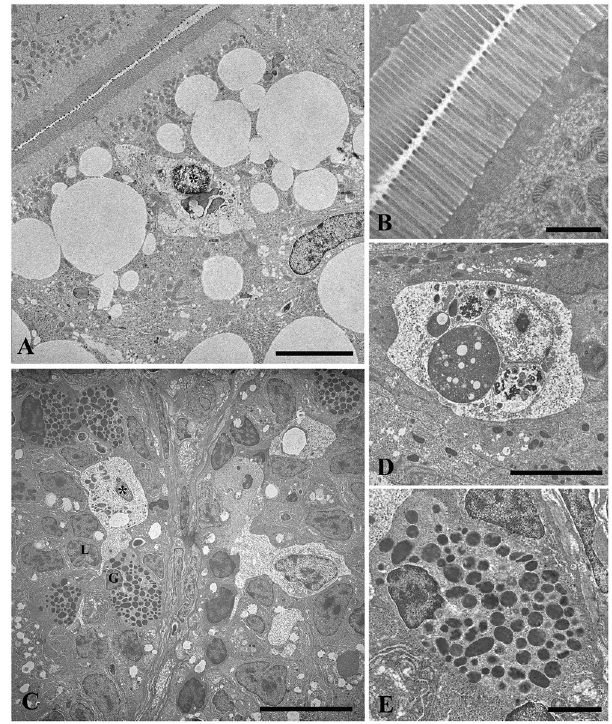
Figure 6. Elevated fat content increases lipid droplets, but did not alter intestinal mucosal epithelium in zebrafish fed a HFD, MFD and LFD. TEM micrograph showing large lipid droplets accumulation in the apical epithelium of enterocytes and intraepithelial macrophages in HFD-C fed fish ( A ). Intact brush border in HFD-C fed fish, ( B ). Macrophages in MFD-C fed fish in contact with the cell membrane of infiltrated lymphocytes and granulocytes ( C ). Intraepithelial macrophages with typical features of phagocytic cells in LFD-C fed fish ( D ). Magnification of intra-epithelium granulocytes in MFD-C fed fish ( E ). L = lymphocyte; G = granulocyte; Asterisk = macrophage. Scale bars: A = 5 µ m, B = 1 µ m, C = 10 µ m, D = 5 µ m, E = 2 µ